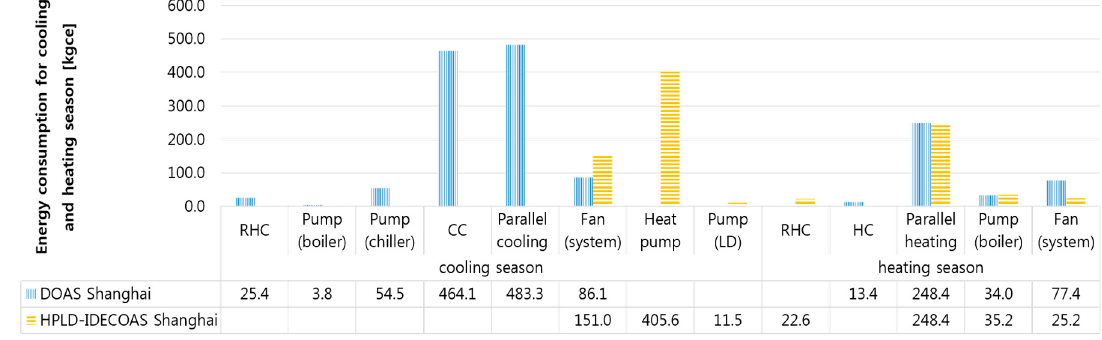
Figure 20. Comparison of seasonal energy consumption in Shanghai.